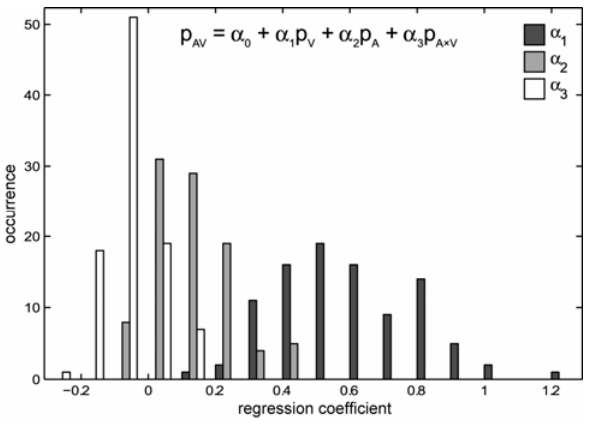
Figure 8. Histogram of the coefficients determined by least squares regression for the equation shown. Regression was performed for ecah AV stimulus, resulting in a total of 24 × 4 (image × sound location) estimates for each coefficient. Intercept coefficients ( ! 0 ) are centred close to 0 and are not shown. Visual coefficients (dark grey) show the greatest contribution to multimodal saliency, followed by auditory coefficients (light grey), and then the smaller and slightly negative multiplicative factor